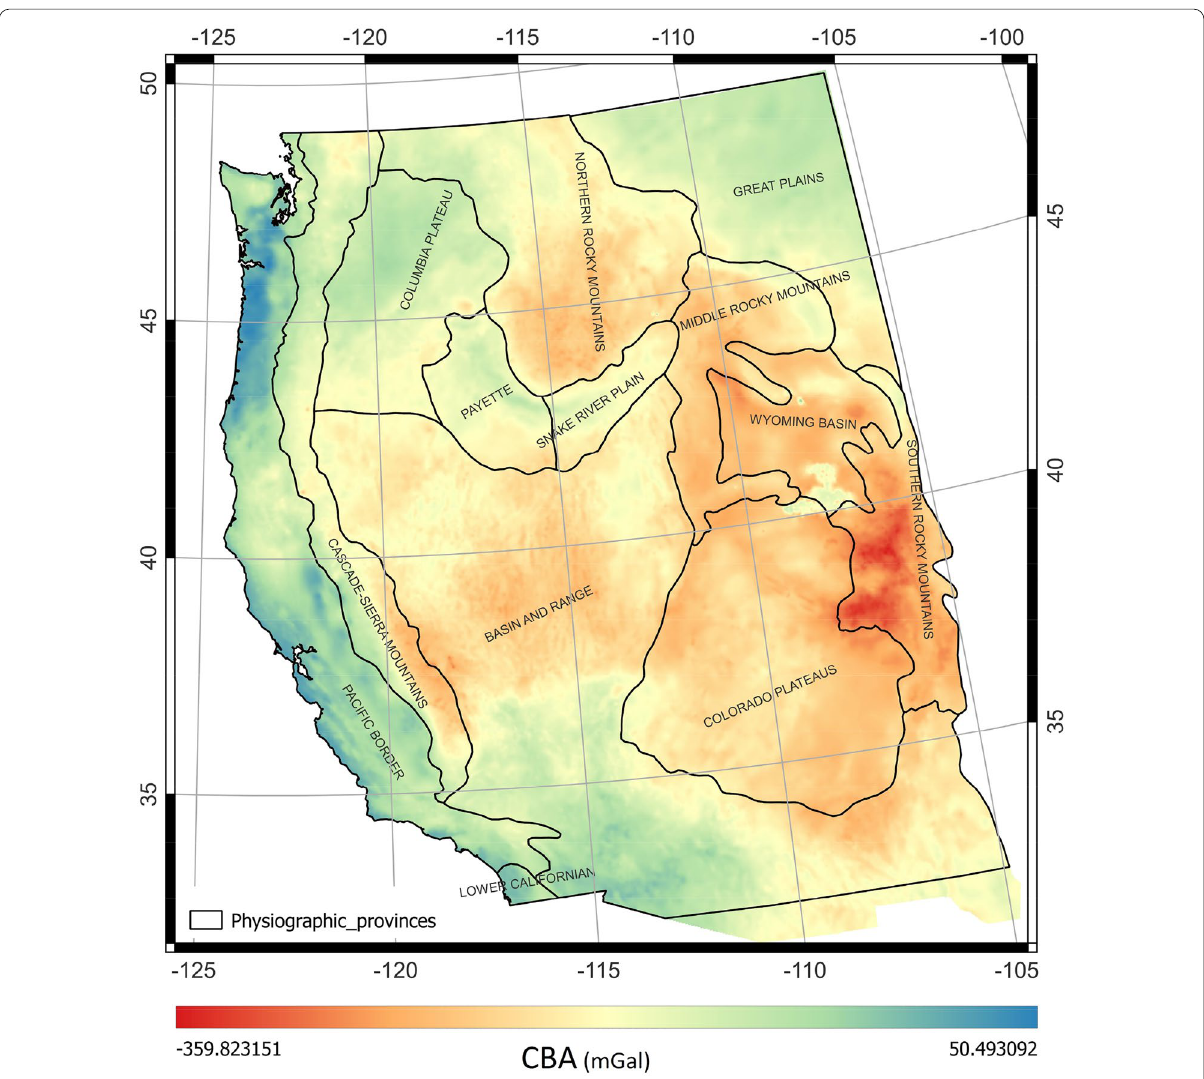
Fig. 3 Complete Bouguer anomaly map of the study